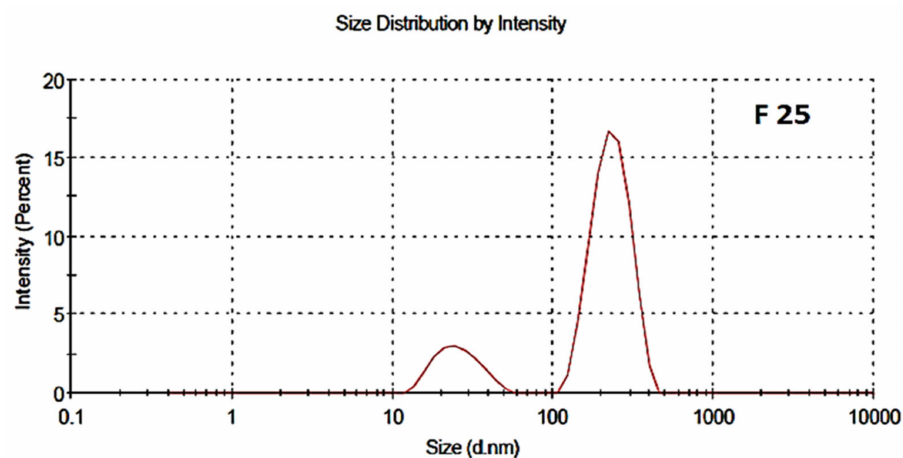
Figure 5. Particle size distribution of drug-Loaded polymeric NPs, F-25.